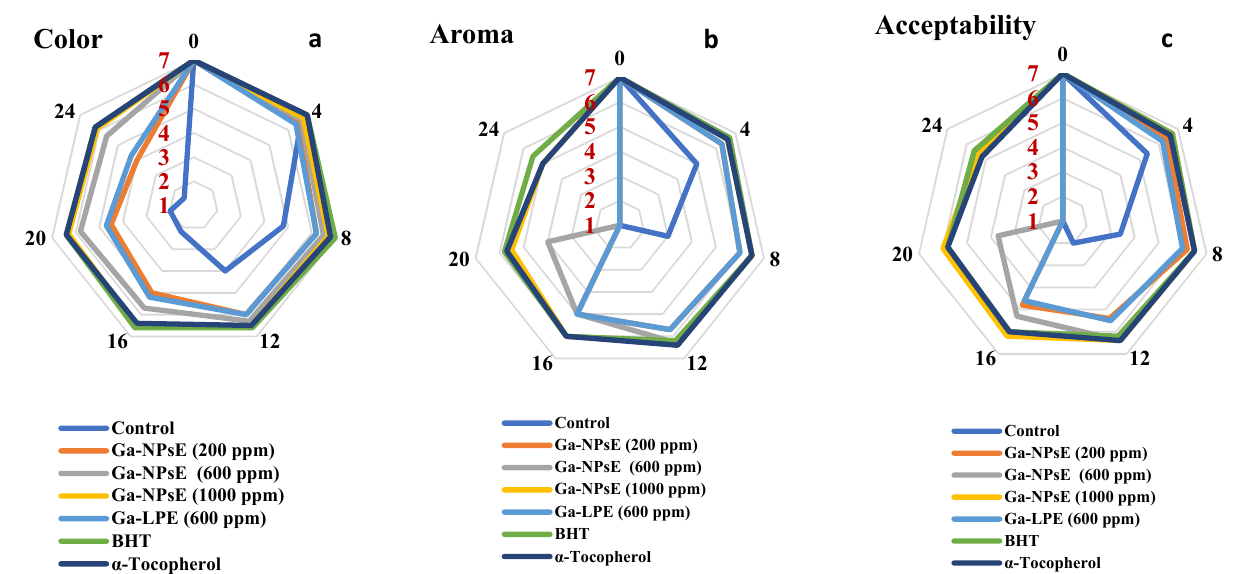
Figure 3. Impact of the addition of Ga-NPs on color ( a ), aroma ( b ), and acceptability ( c ) in SFO samples during storage at (65 °C).